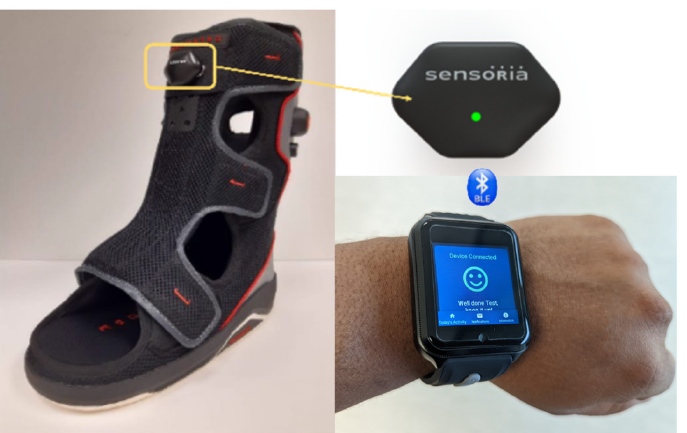
Figure 3. The overall smart offloading system, used by participants assigned to use the smart removable cast walker (sRCW). The system consists of a sensor that attaches to the cast walker, as well as a watch that provides the participant notifications regarding their adherence.